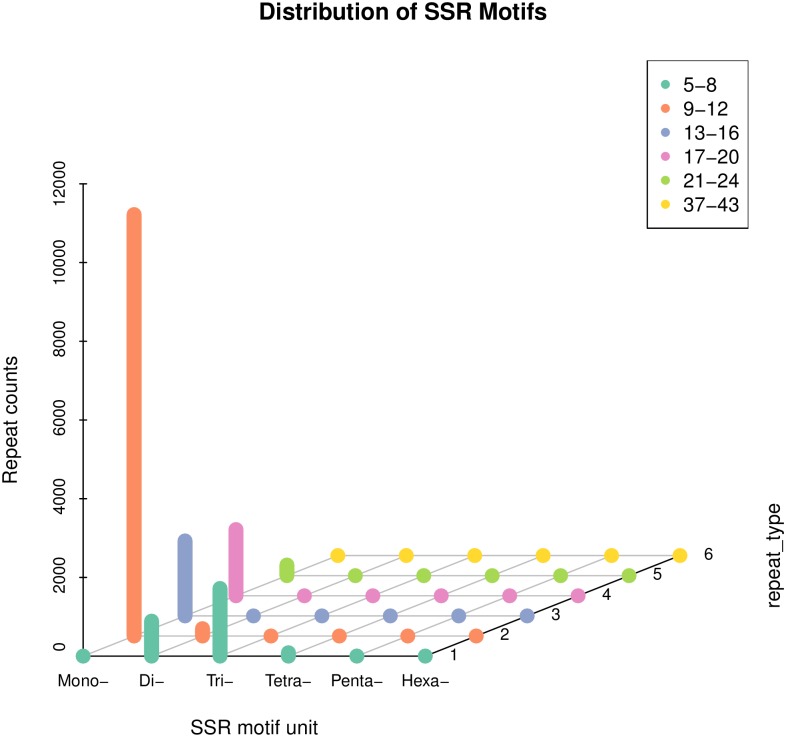
Frequency of SSRs in C. Ciliata transcriptomes.